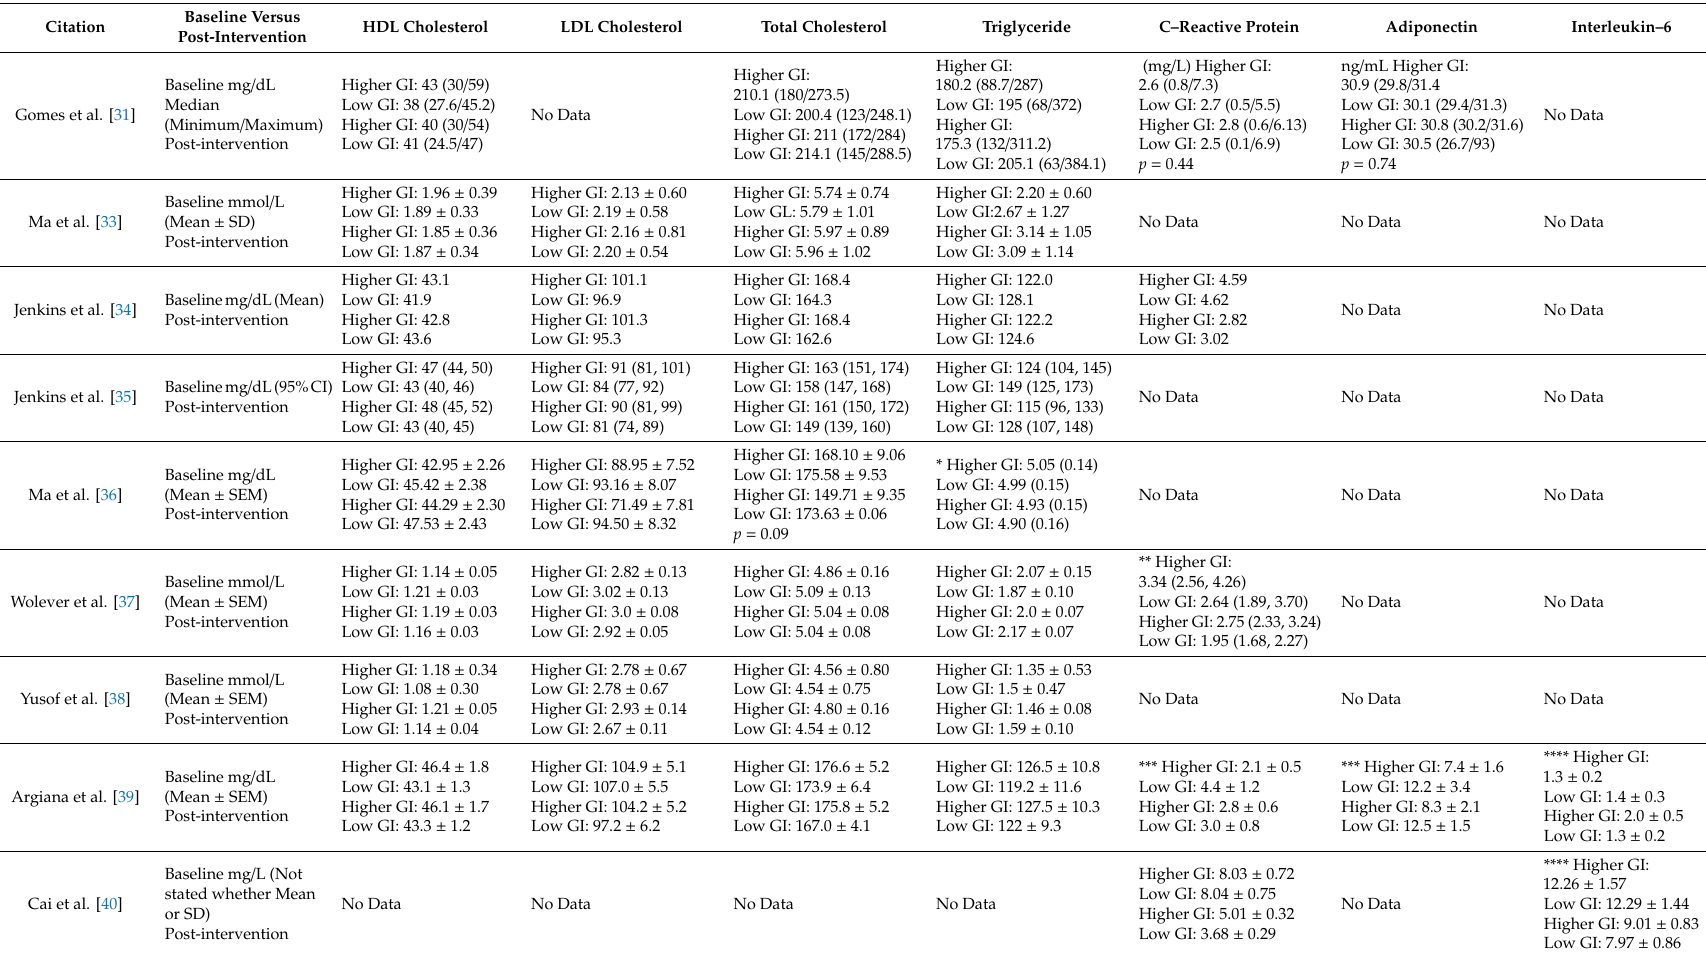
Table 4. Cardio–metabolic and inflammatory parameters of studies